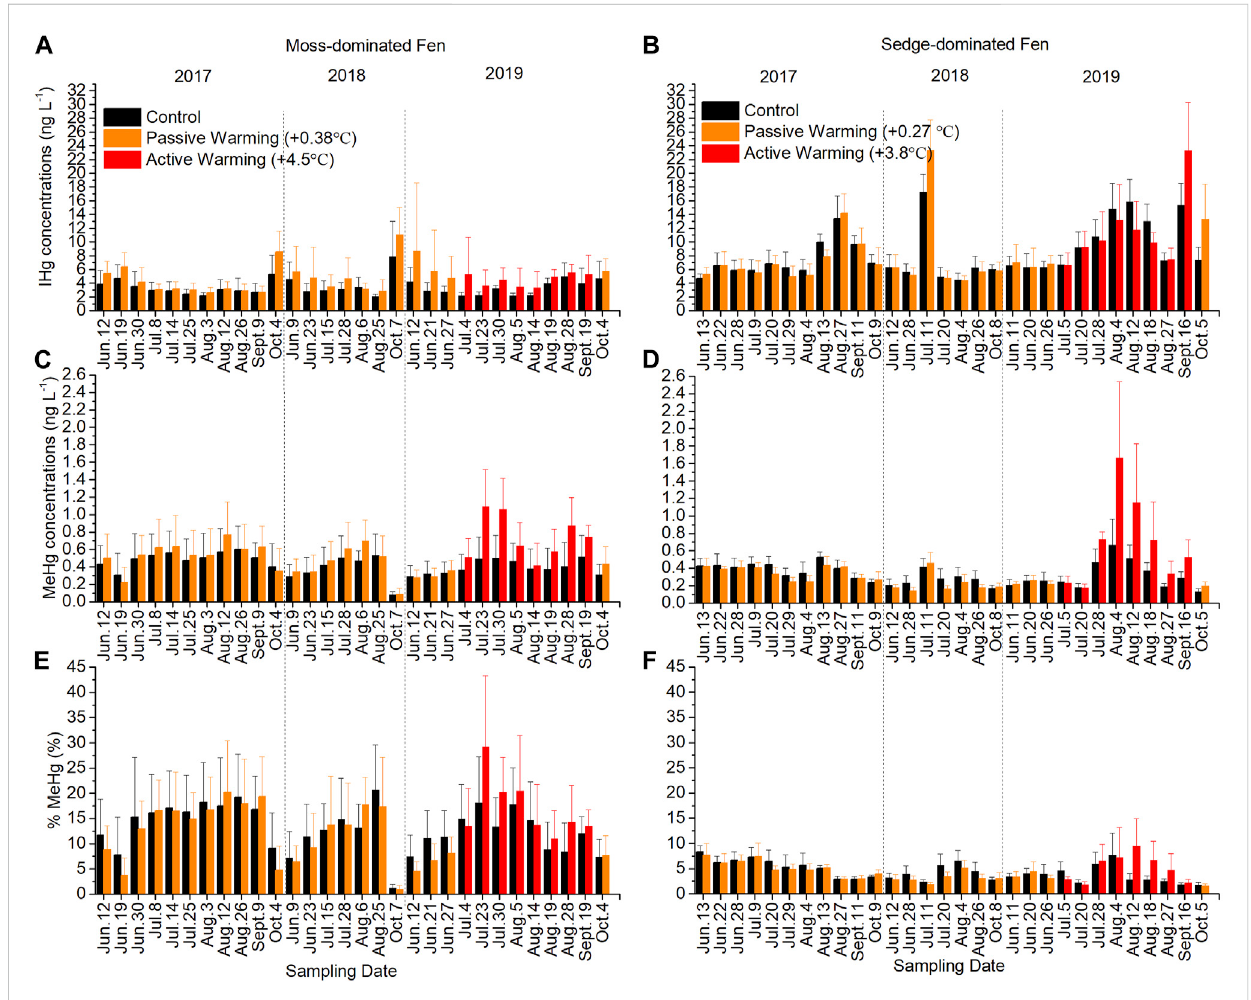
FIGURE 3 Concentrations of inorganic mercury (IHg) and methylmercury (MeHg) and the proportion of total Hg (THg) as MeHg (%MeHg) in pore waters in the controlandwarmedplotsinthemoss-dominatedfenandthesedge-dominatedfenovertheexperiment.PorewaterIHgconcentrationsin (A) themoss- dominated fen and (B) the sedge-dominated fen; pore water MeHg concentrations in (C) the moss-dominated fen and (D) the sedge-dominated fen; % MeHg changes in pore waters in (E) the moss-dominated fen and (F) the sedge-dominated fen. Colors are different plot treatments: black for the control plots; orange for the passively warmed plots; red for the actively warmed plots. Bars are mean values and whiskers are ± one standard